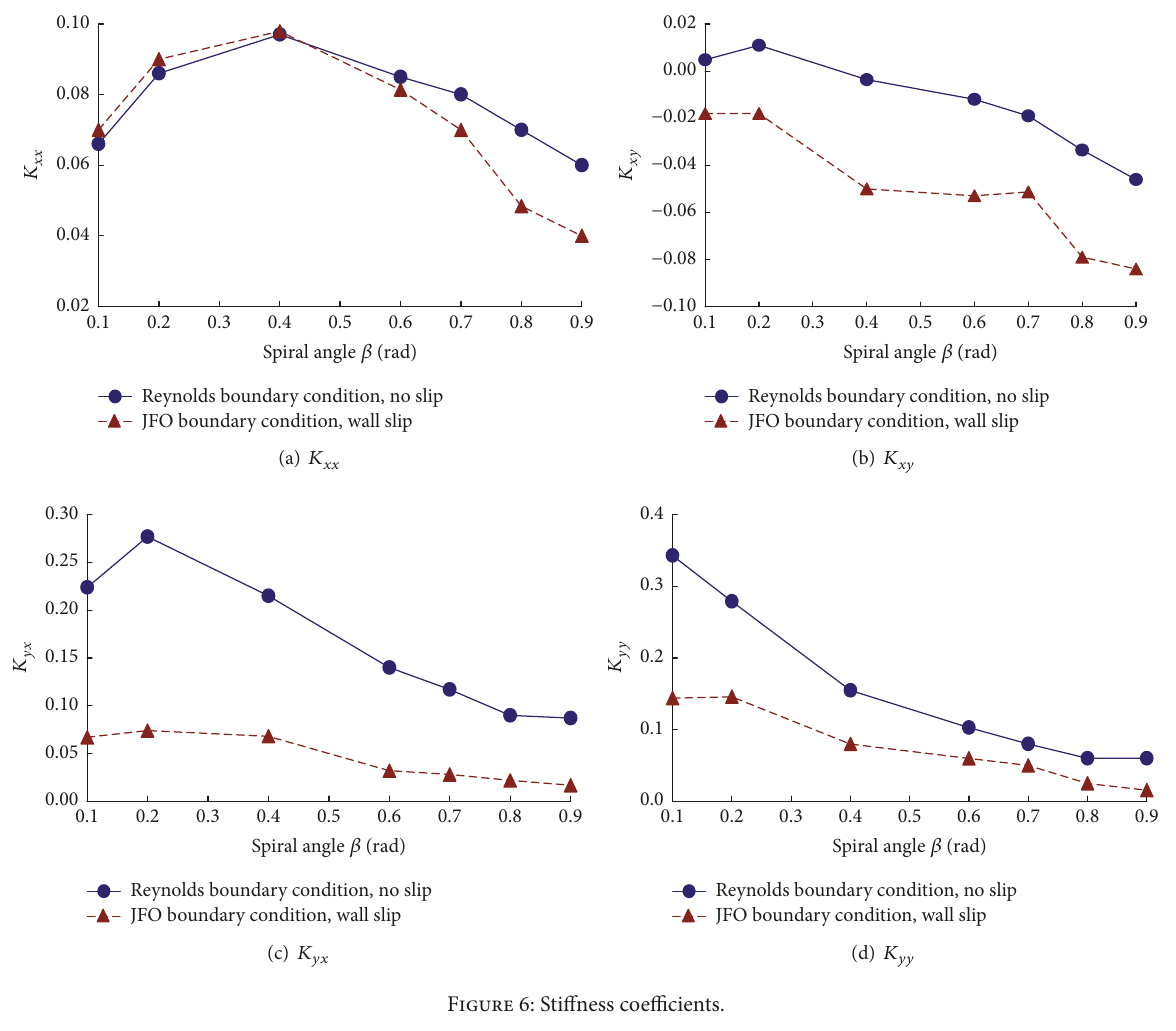
Figure 6: Stiffness